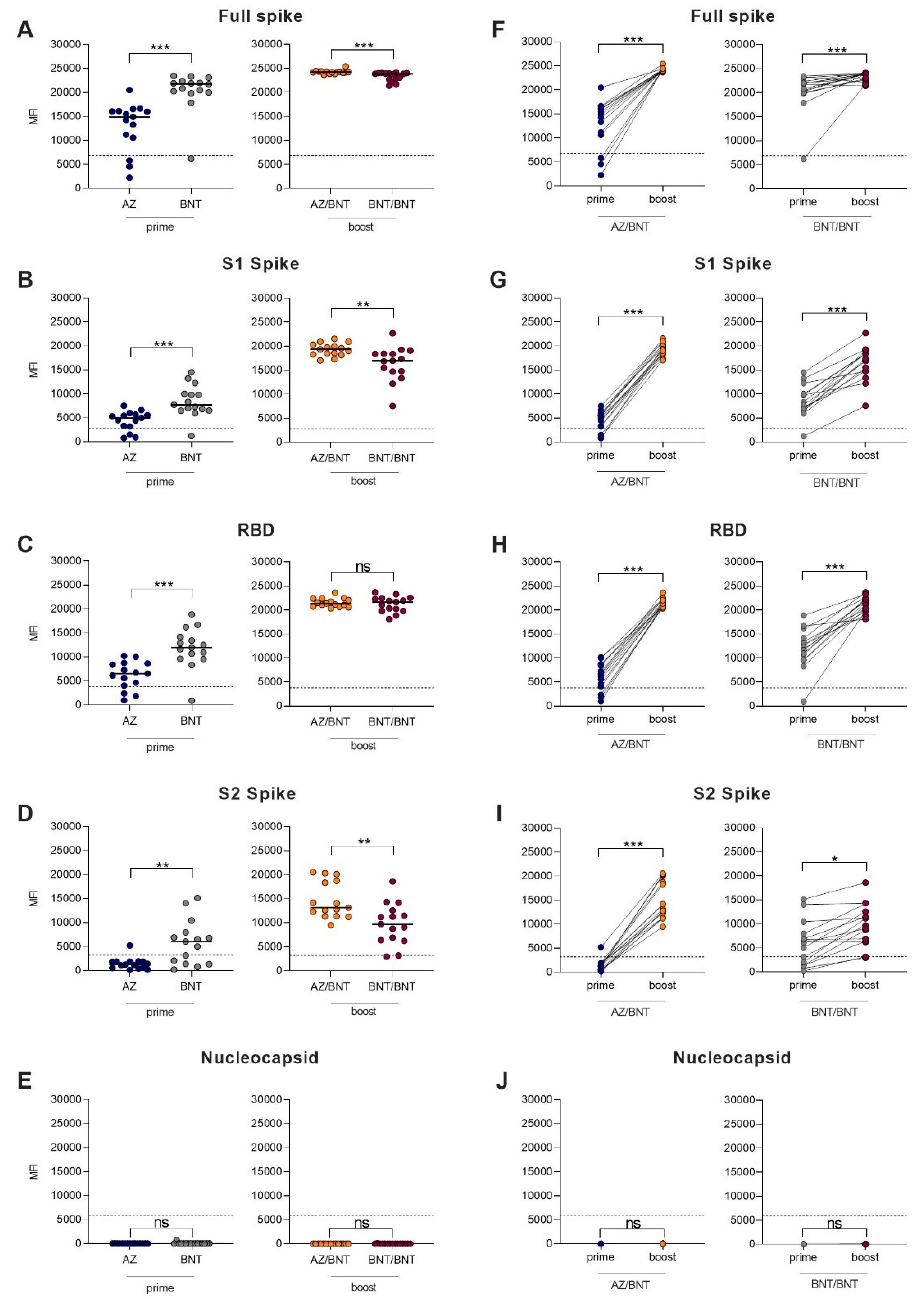
Figure 3. IgG antibodies against different SARS-CoV-2 target antigens in health care workers after AZ and BNT prime vaccination and after AZ/BNT heterologous and BNT/BNT homologous boost vaccination. Detection of antibodies against the full spike protein ( A ), the S1 spike protein ( B ), the receptor-binding domain of the spike protein ( C ), the S2 spike protein ( D ), and the nucleocapsid protein ( E ) of SARS-CoV-2 in health care workers after AZ and BNT prime vaccination and after AZ/BNT heterologous and BNT/BNT homologous boost vaccination. The x -axis represents the vaccination pattern, and the y -axis the mean fluorescence intensity value of the reactivity. The dashed black line represents the cutoff for detection for each target, respectively. The paired detection of antibodies against the full spike protein ( F ), the S1 spike protein ( G ), the receptor-binding domain of the spike protein ( H ), the S2 spike protein ( I ), and the nucleocapsid protein ( J ) after the first and second vaccination in health care workers with either AZ/BNT heterologous and BNT/BNT homologous boost vaccination. The x -axis represents priming and boosting dose and the y -axis the mean fluorescence intensity value of reactivity. * p < 0.05; ** p < 0.01; *** p < 0.001.